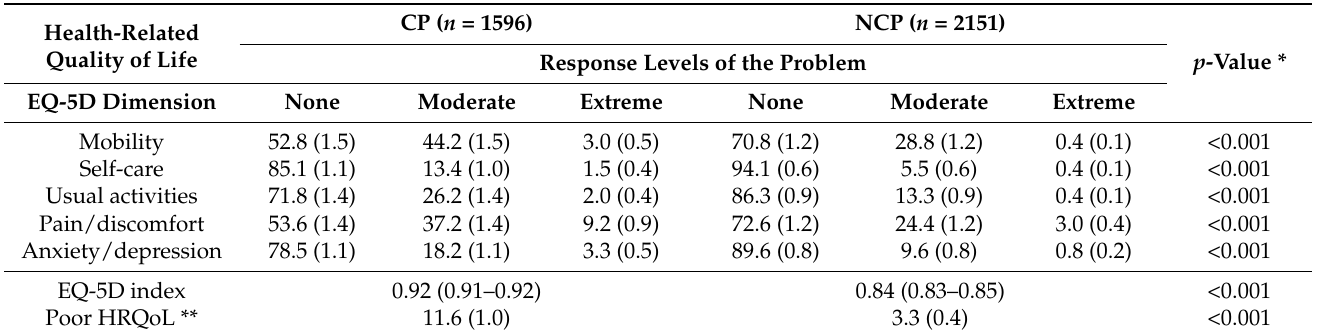
Table 2. Health-related quality of life by chewing problems in elderly